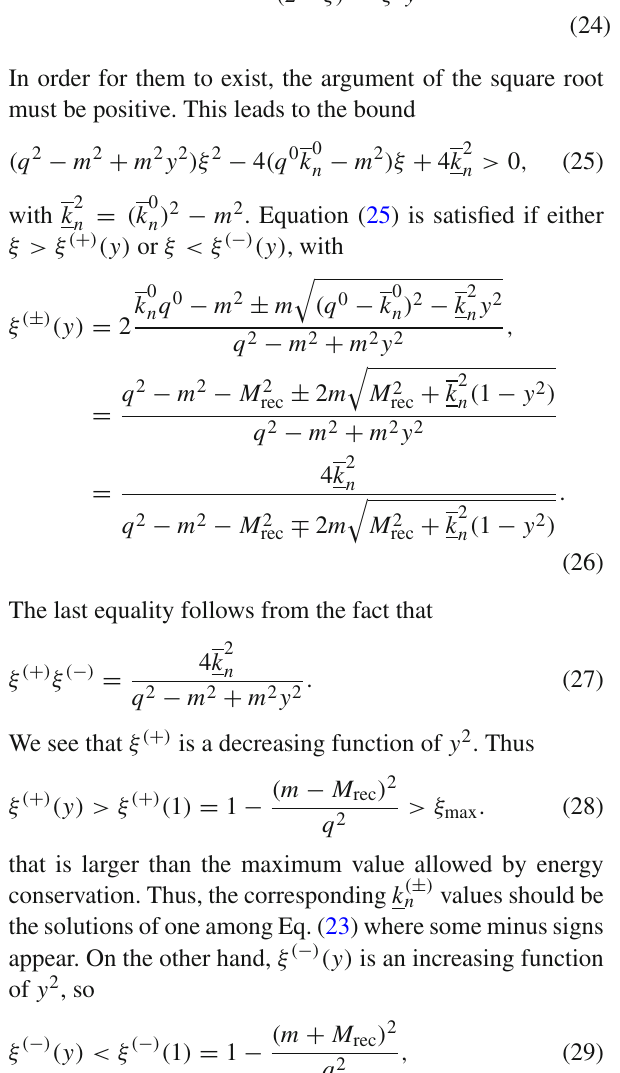
Fig. 2 Kinematic reconstruction of the real emission kinematics with positive (left) and negative k n values. The angle θ is fixed by y = cos θ